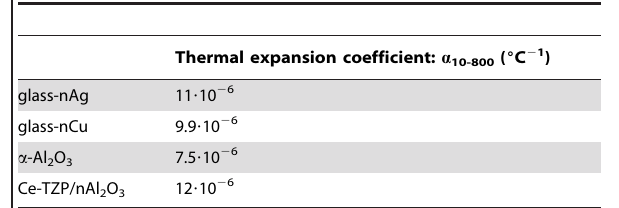
Figure 1. Diffusion method for E. coli for the uncoated and coated alumina substrates obtained at 740 6 C for n-Ag glass and at 850 6 C for the n-Cu glass. A similar result was obtained for zirconia substrates.